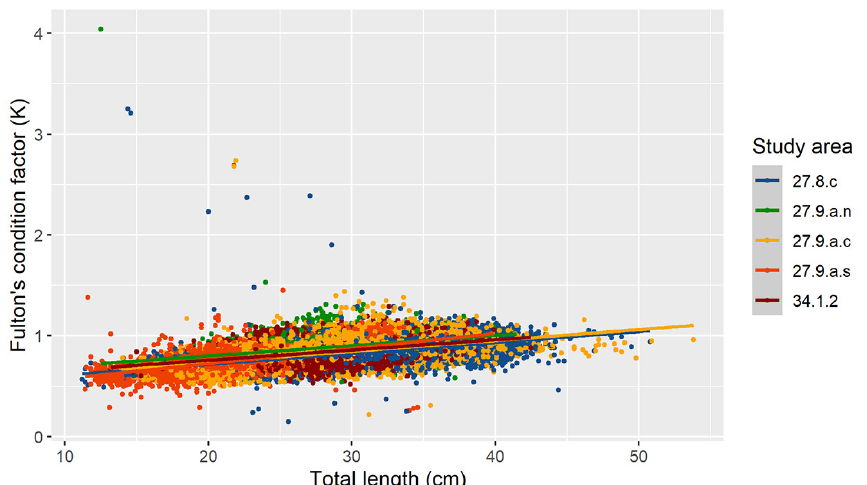
Fig. S6. – Relationship between Fulton’s condition factor (K) and Atlantic chub mackerel total length (cm) in each study area. Geographical study areas from south to north are 34.1.2, Canary Islands; 27.9.a.s, Gulf of Cadiz; 27.9.a.c, W Portuguese coast; 27.9.a.n, NW Spanish coast; 27.8.c., Cantabrian